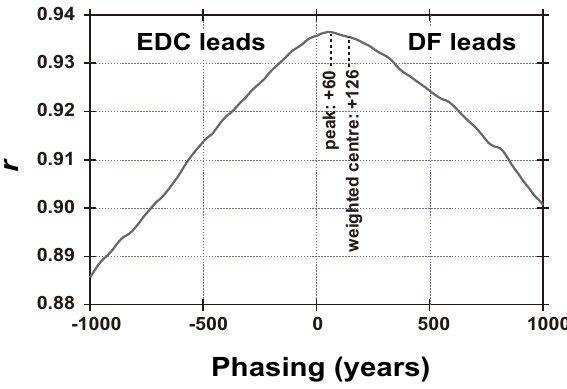
Figure 7. In order to see the average phasing over the 216kyr, the correlation coefficient ( r in the left axis) of the δ D ice records, shifted by x years (bottom axis), was calculated. r has a peak value when DF leads by + 60 years. Considering the asymmetry of the peak shape, the weighted centre was calculated to be + 126